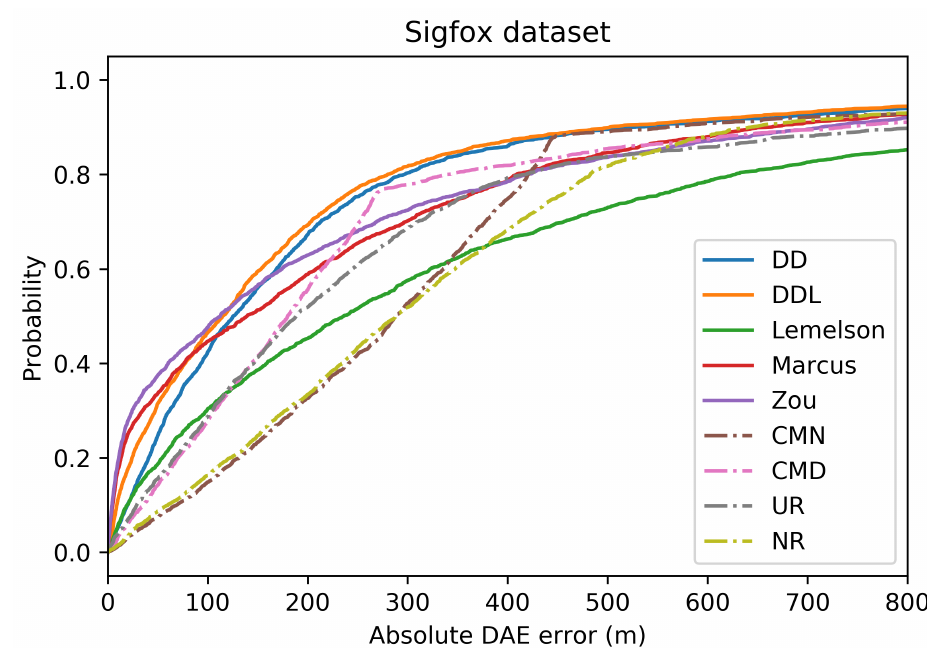
Figure 4. The Cumulative Distribution Function (CDF) of the absolute DAE error (in meters), for all studied methods and baselines, in the validation set of the Sigfox